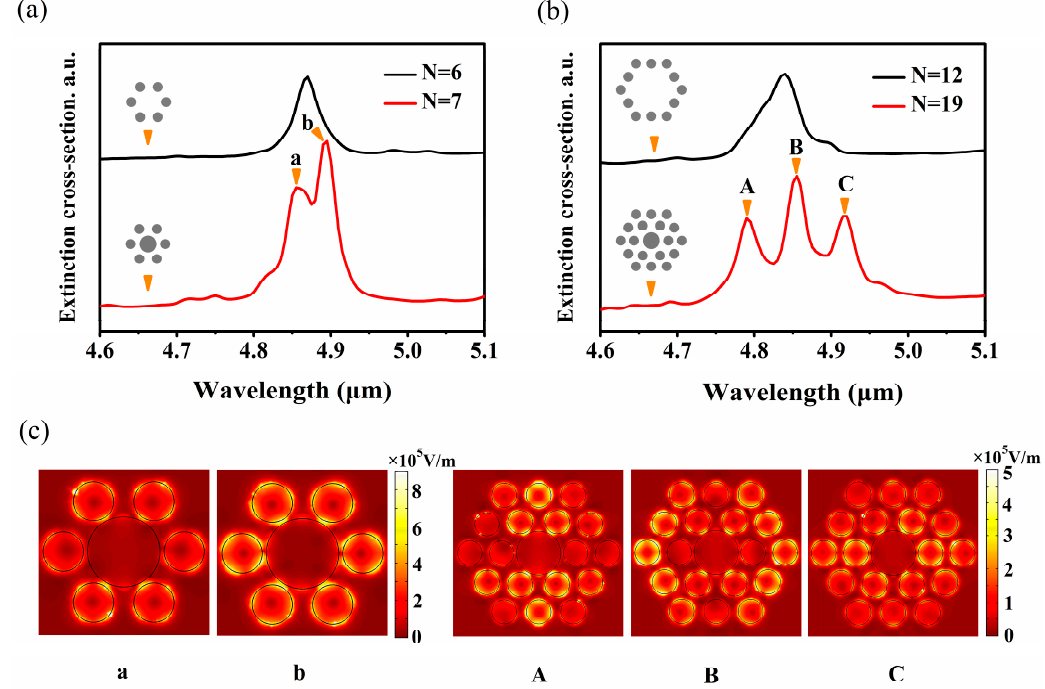
Figure 2. ( a ) Extinction spectra of hexamer (black) and heptamer (red). ( b ) Extinction spectra of the outer ring nanostructure (black) and PMM structure with 19 nanodiscs (red). ( c ) The normalized electric field distributions ( | E | ) of peak a, b, A, B, and C.